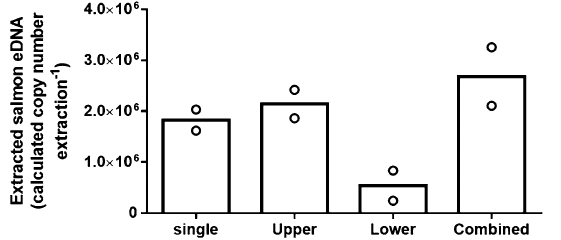
Figure 2. Calculated eDNA concentrations extracted by various protocols at ( A ) high (neat chum salmon seawater) and ( B ) low (10×-diluted chum salmon seawater) inputs (N = 6). Each cartridge was extracted three times with the same protocol and the eDNA concentration was quantified separately. Data is presented as mean ± S.E.M. For protocol-dependent effects, Tukey’s test was performed after two-way ANOVA and different alphabet letters denote significant difference ( p < 0.05) among protocols and repeated